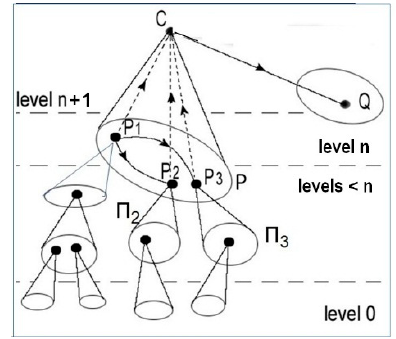
Figure 2. A hierarchical category with a ramification of an object C.